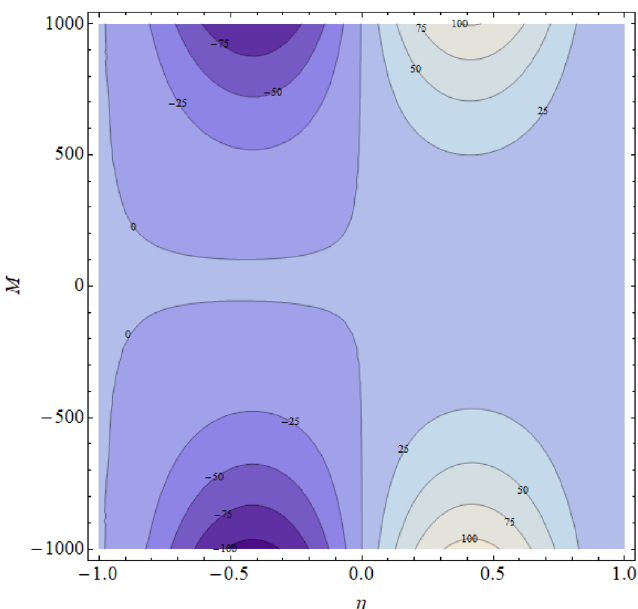
Figure 11. Contour upshot due to the variation in M .